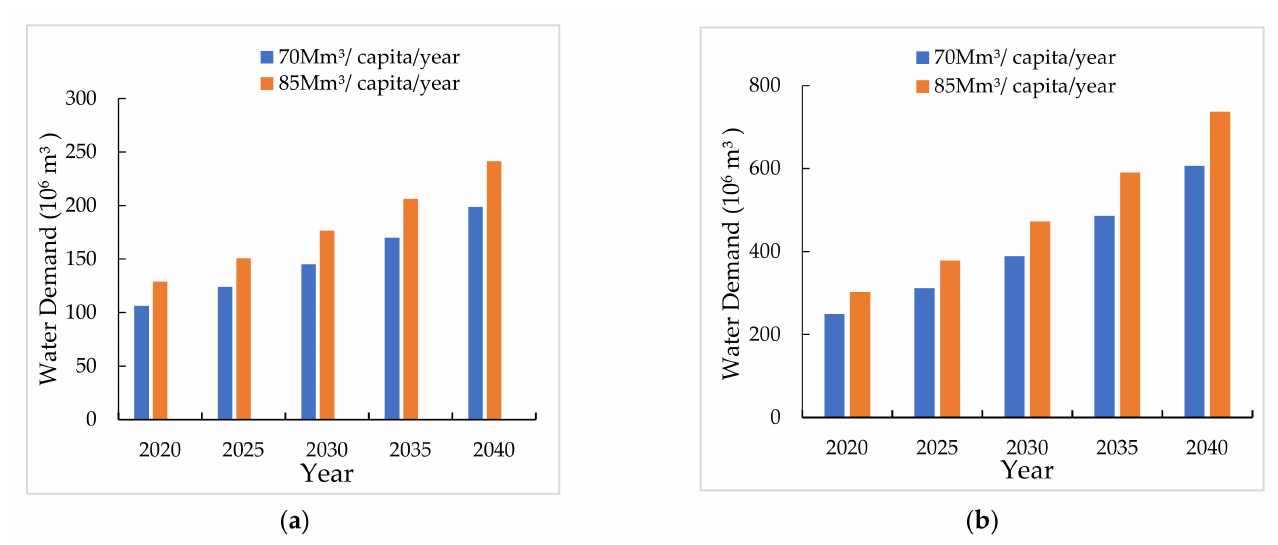
Figure 8. Domestic water demand estimation for Sana’a region: ( a ) Sana’a governorate, with a 3.2% population growth rate; ( b ) Sana’a city, with a 4.5% population growth rate.